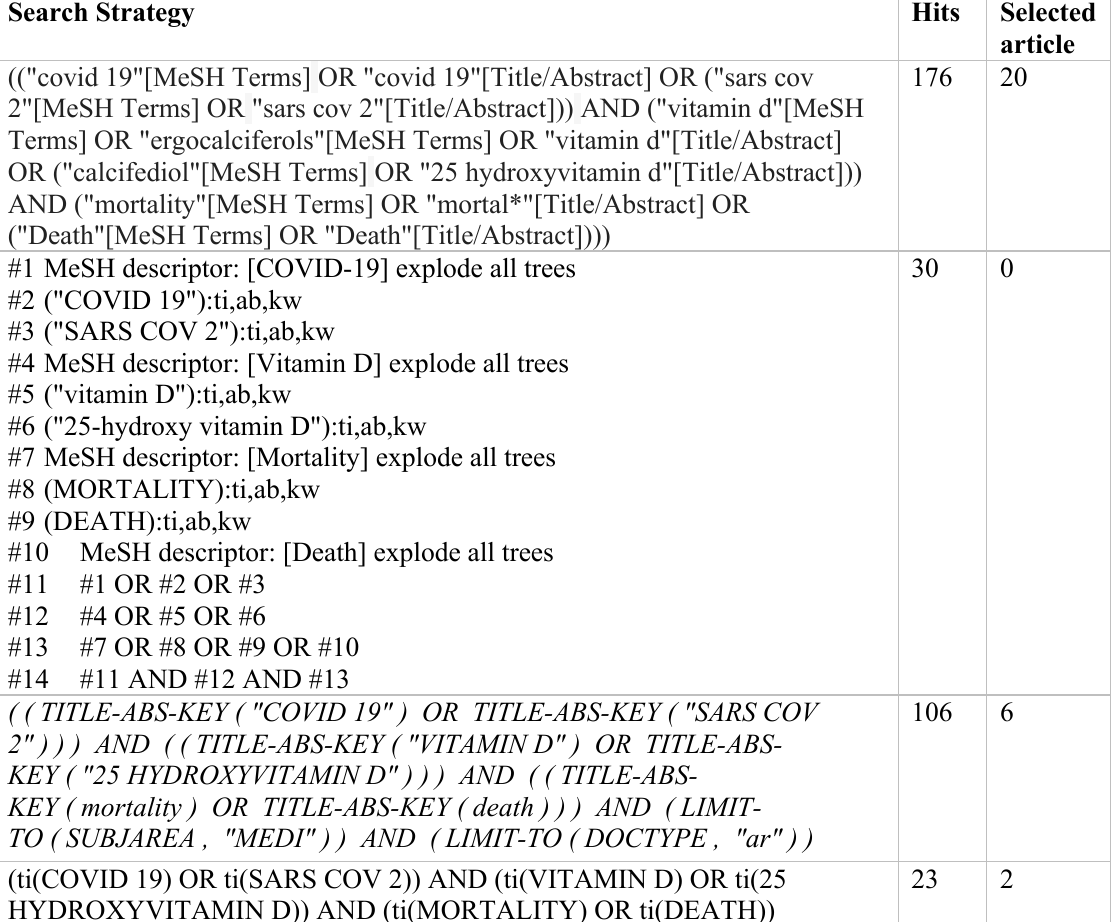
Table 1 . Literature searching strategy Database Search Strategy Hits Selected Pubmed